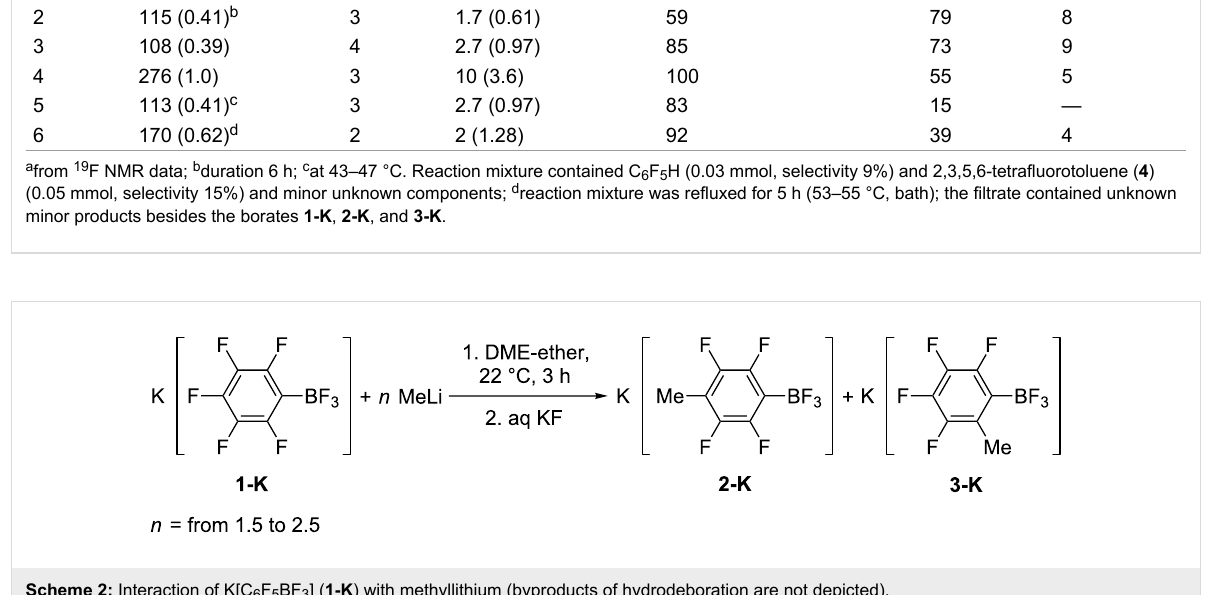
Table 2: Reaction of M[C 6 F 5 BF 3 ] ( 1-M ) with butyllithium (22 °C, 2 h). entry